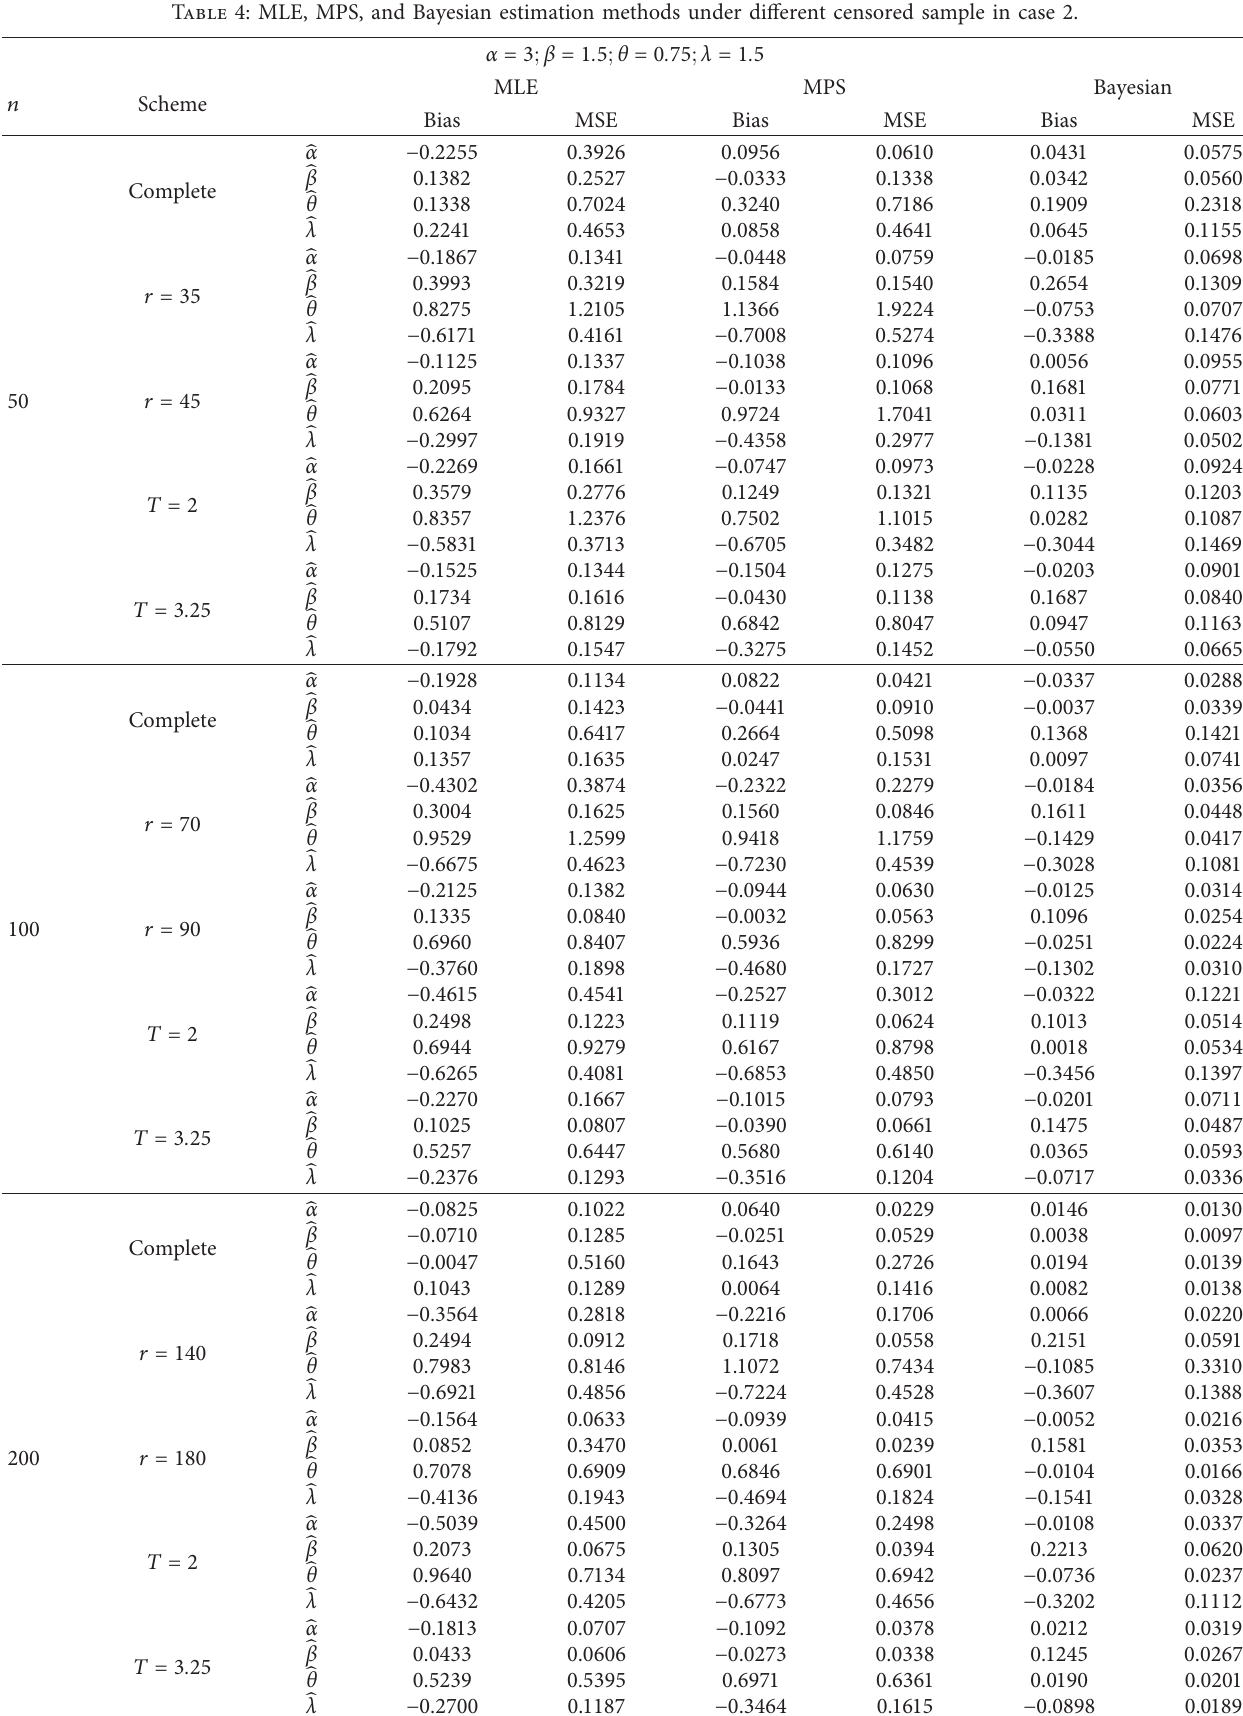
Table 4: MLE, MPS, and Bayesian estimation methods under different censored sample in case